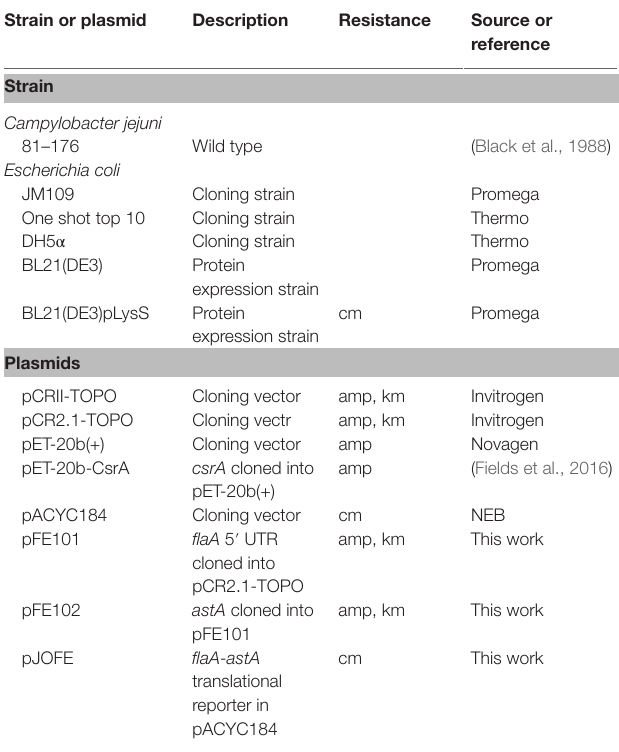
TABLE 1 | Bacterial strains and plasmids used in this